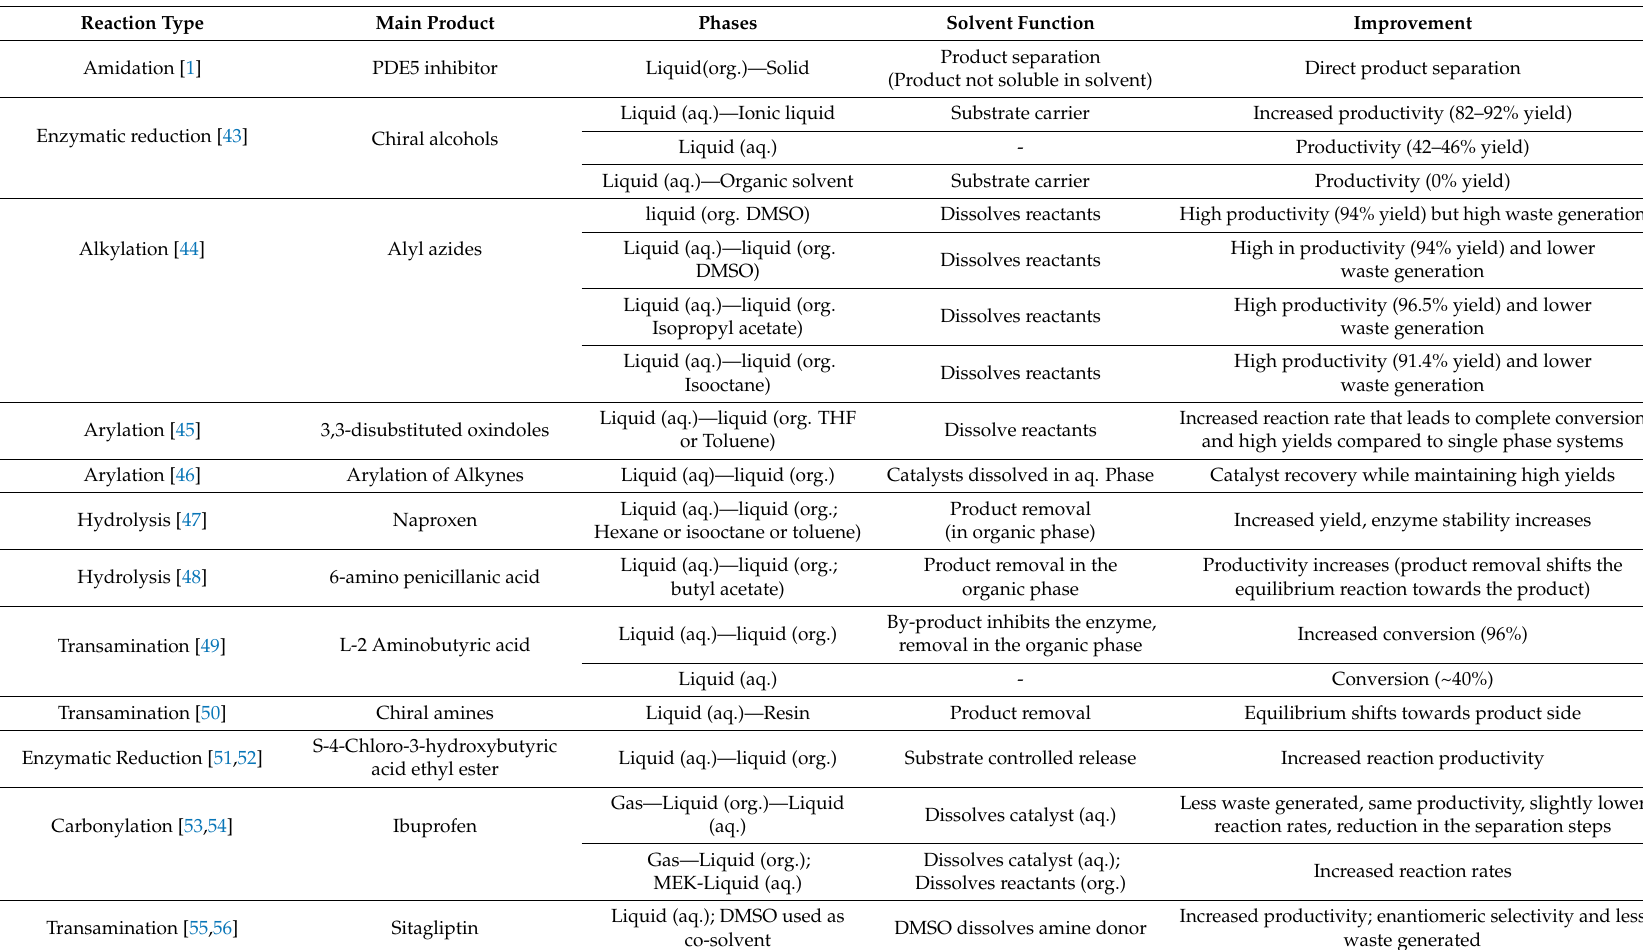
Table 9. List of reactions where the use of the solvent has a specific function that leads in direct reaction performance